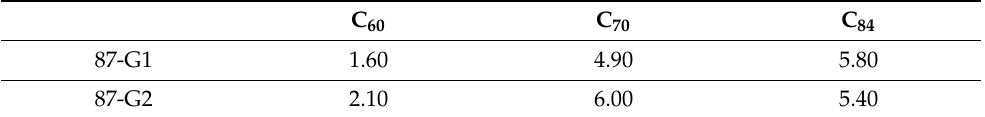
Table 9. Stability constants, K a × 10 4 [M − 1 ], of the 87G1 and 87G2 complexes with C 60 , C 70 ,